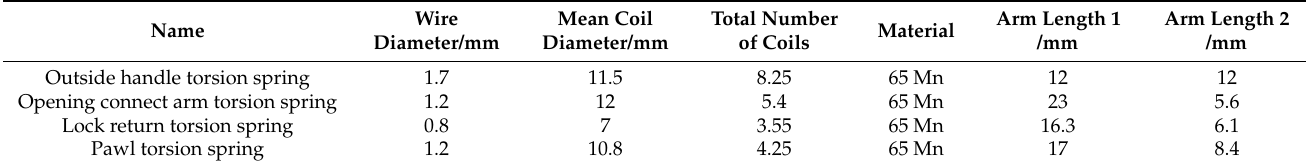
Table 1. Torsion spring parameter table.